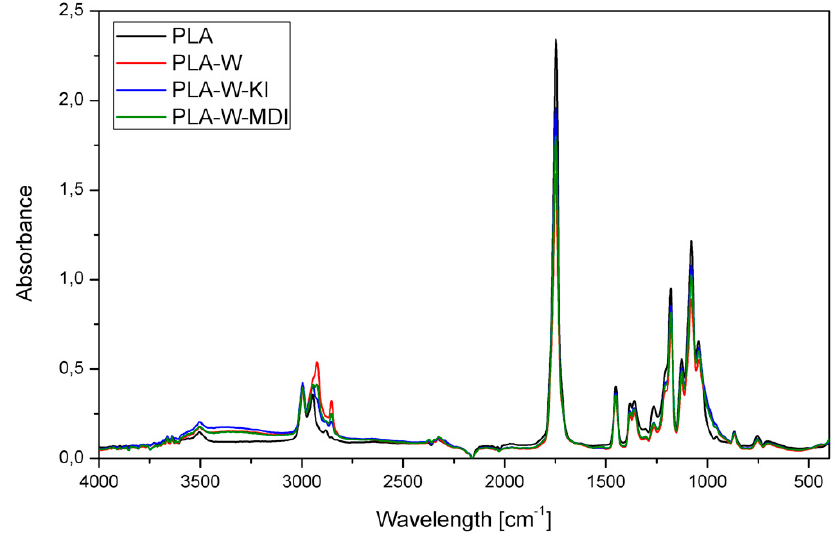
Figure 7. FTIR spectra of polylactide (PLA) and PLA composites filled with vermiculite subjected to various chemical treatments.